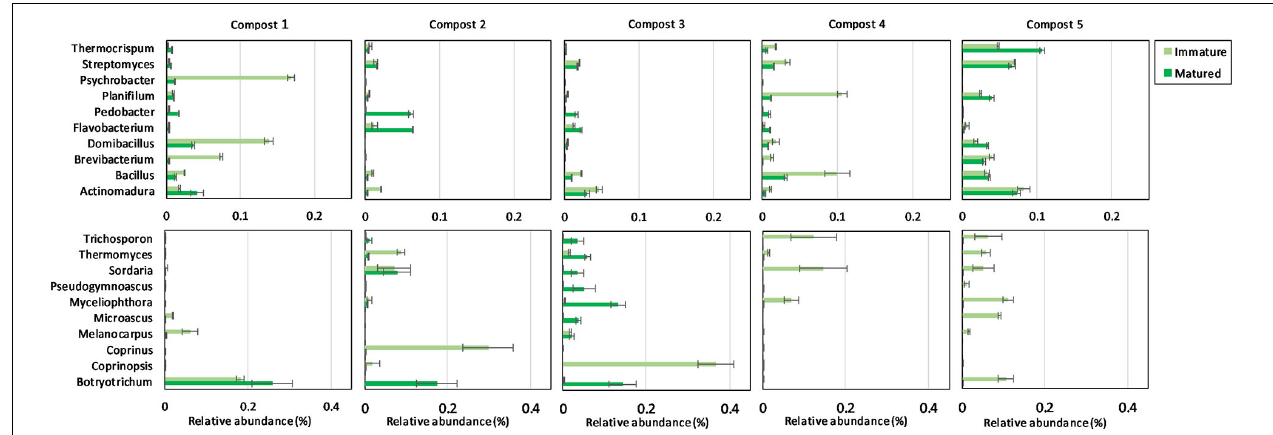
FIGURE 3 | Microbial composition of immature and matured composts. On top: relative abundances (percentages) ± standard error of the ten most abundant bacterial genera (16S V3-V4 region rRNA gene) of immature and matured composts in the different compost batches. At the bottom: relative abundances (percentages) ± standard error of the ten most abundant fungal genera (ITS2 gene) of immature and matured composts in the different compost batches.